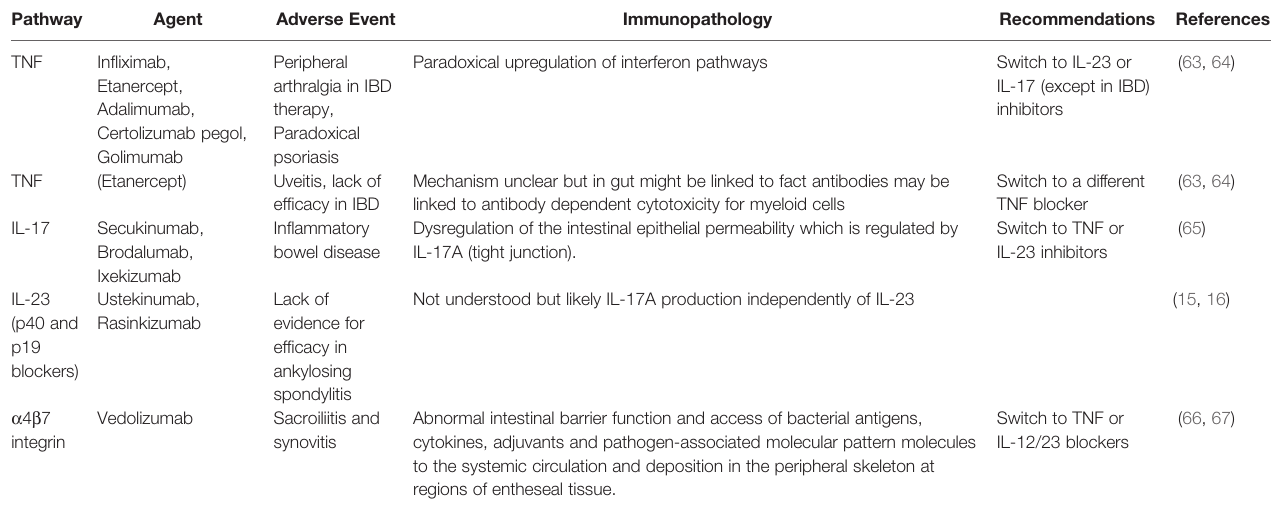
TABLE 1 | Spondyloarthritis spectrum disease heterogeneity in immunotherapy responses.